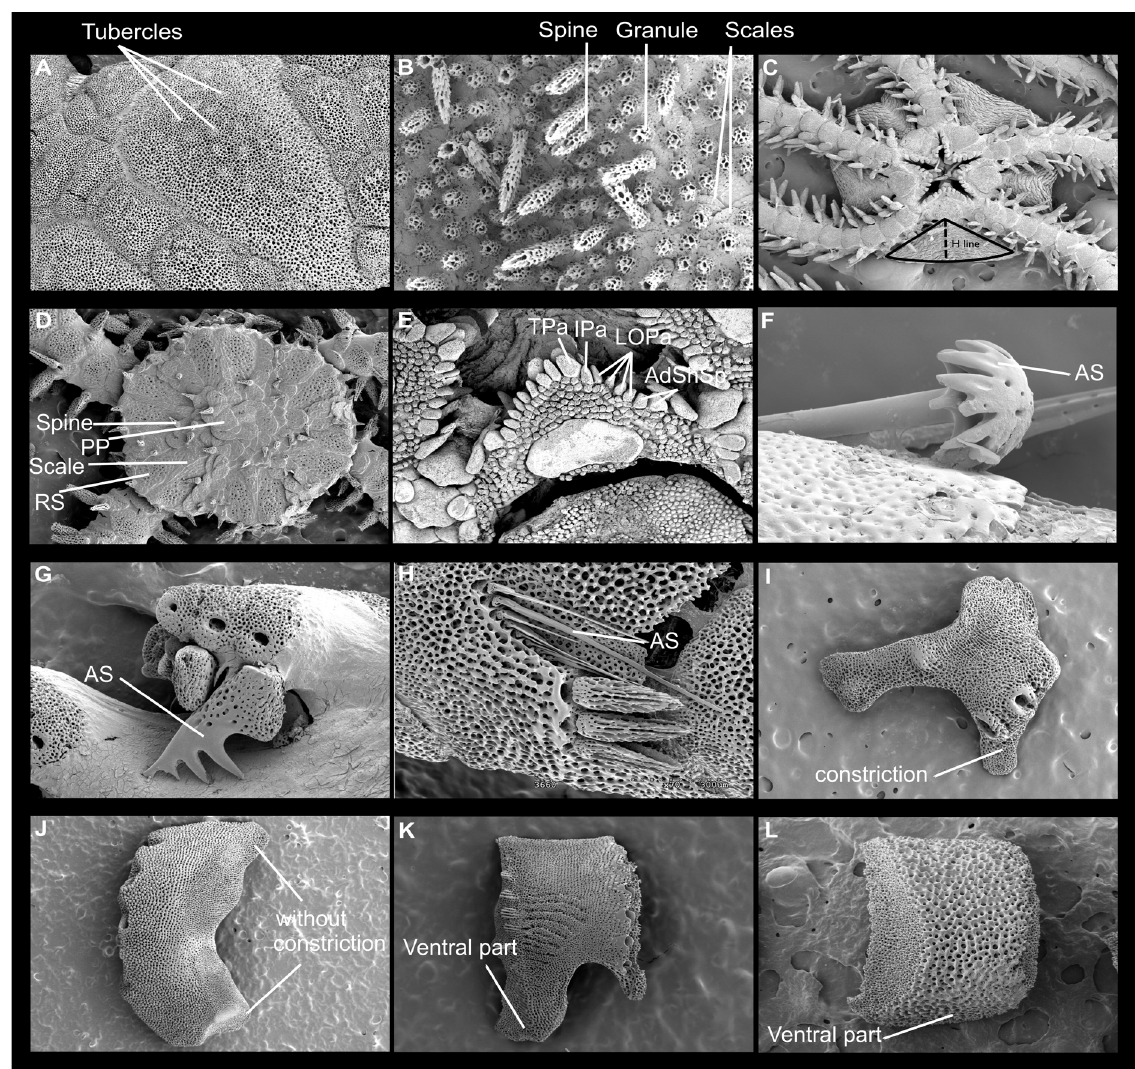
Fig. 2. SEM images of various brittle star ossicles. A–E . Disc structures. A . Dorsal disc, radial shield with tubercles ( Ophiomusa lymani (Wyville-Thomson, 1873)). B . Dorsal disc ( Ophiolimna bairdi (Lyman, 1883)). C . Ventral disc ( Ophionereis porrecta Lyman, 1860), the interradius is assumed as a triangle and H gives its height. D . Dorsal disc, triangular radial shield ( Ophiactis savignyi (Müller &